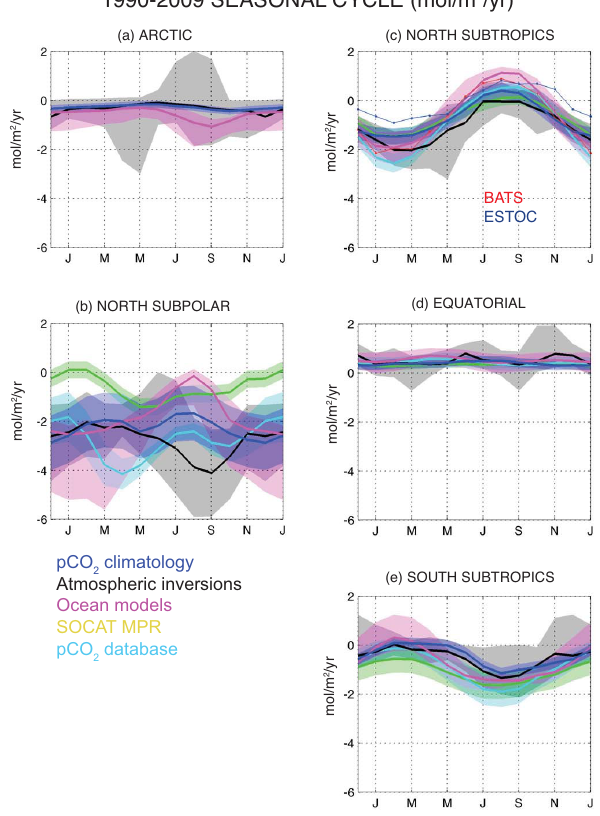
Fig. 5. Mean seasonal cycles of sea–air CO 2 flux density [molm − 2 yr − 1 ] for the (a) Arctic, (b) North Subpolar, (c) North Subtropics, (d) Equatorial, and (e) South Subtropics for the p CO 2 climatology (light blue), atmospheric inversions (black), and ocean biogeochemical models (magenta), SOCAT MPR (green), p CO 2 database (cyan), and at the BATS and ESTOC sites in the North Subtropics (dark blue and red, respectively). Shading indicates the spread between maximum and minimum from the atmospheric in- versions and ocean biogeochemical models, 50% of the mean for the p CO 2 climatology and SOCAT, and the uncertainty of the har- monic fit for the p CO 2 database IAV. Means are calculated both spatially and using all years available for each